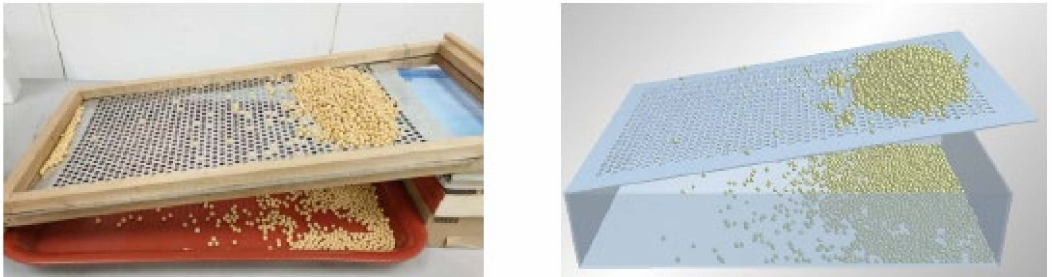
Figure 6. Test and simulation diagrams of self-flow